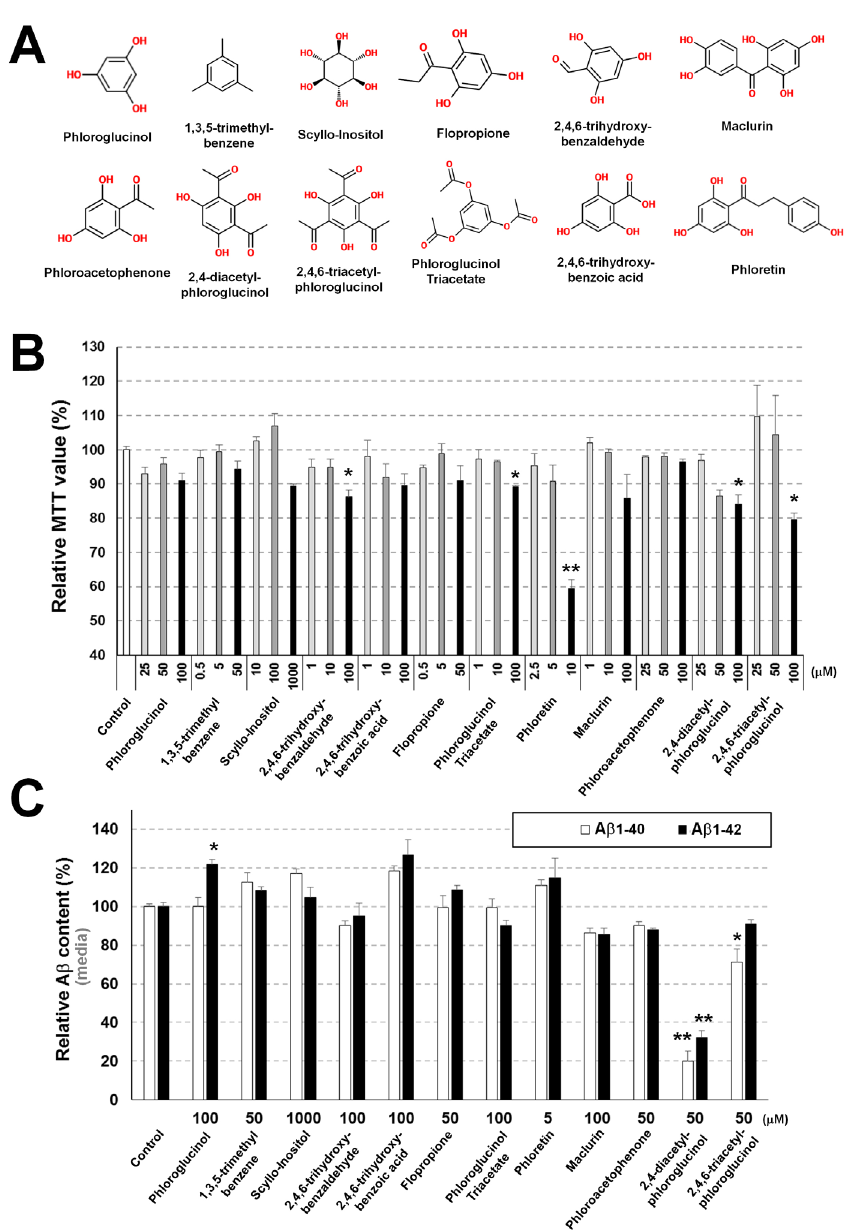
Figure 1. Screening for low molecular weight and commercially available phloroglucinol derivatives decreasing A β levels. ( A ) Chemical structures of the phloroglucinol derivatives screened in the present study. ( B ) MTT reduction assay analysis after treatment of 293sw cells with different doses of the compounds for 8 h. The column color indicates the low (light gray), medium (gray), and high (black) doses of each individual compound. The concentration range for each compound was determined through 3-4 independent repeated measurement. ( C ) ELISA analysis of A β 1–40 and A β 1–42 levels in the culture medium of 293sw cells treated with the indicated doses of compounds for 8 h. Values in panels B and C are presented as means ± SEMs (n = 3). Statistical significance of the differences between treated cells and untreated controls were determined using Student’s t-test (* p < 0.05, ** p < 0.01).